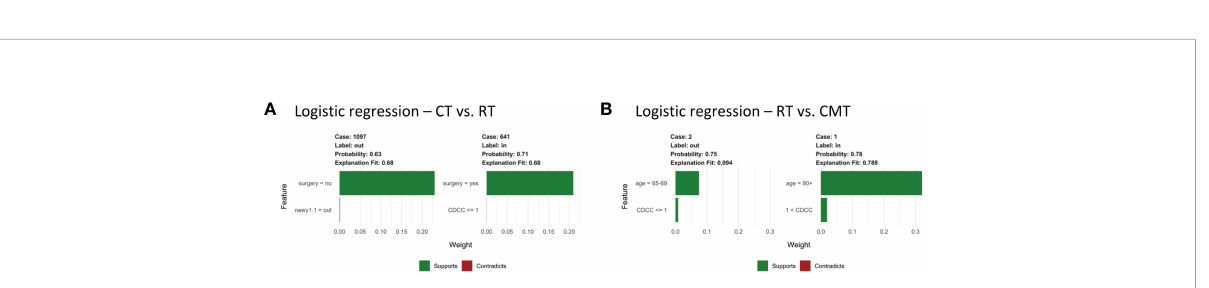
FIGURE 6 Subject-level Local Interpretable Model-Agnostic Explanations for propensity scores estimated by logistic regression from glioblastoma data comparing both (A) chemotherapy vs. radiation and (B) radiation vs. combined modality therapy. Each graphic identi fi es the most deterministic individual-level features in classifying matched ( “ in ” ) or unmatched ( “ out ” ) status and notes whether this trait supports or contradicts the probability ascribed by the decision tree. Weights indicate how strongly representative each feature is of the classi fi cation.